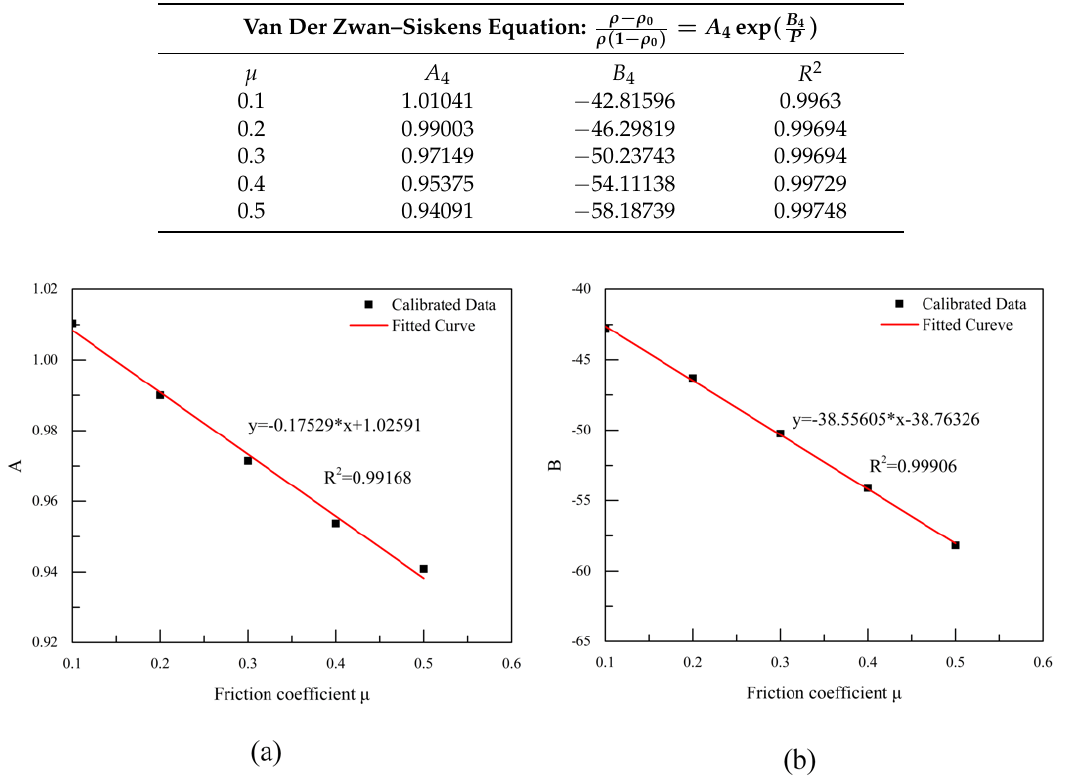
Table 2. Fitting parameters of Van Der Zwan–Siskens equation with different die wall friction coefficients. Figure 15. Evolution of the average relative density with compaction pressure at different die wall friction coefficients.